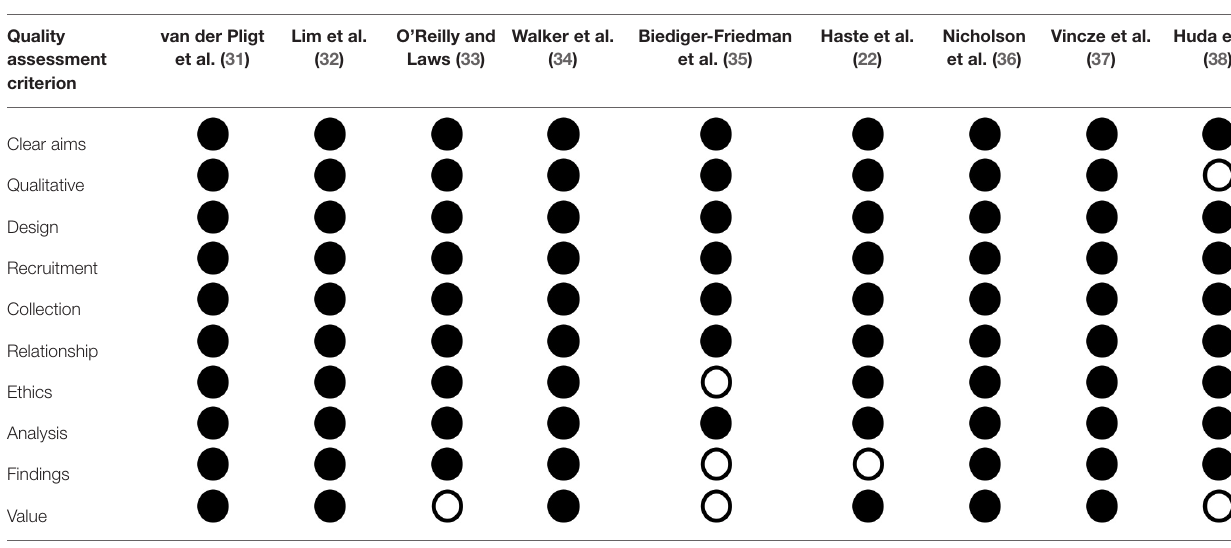
TABLE 2 | Quality assessment of included